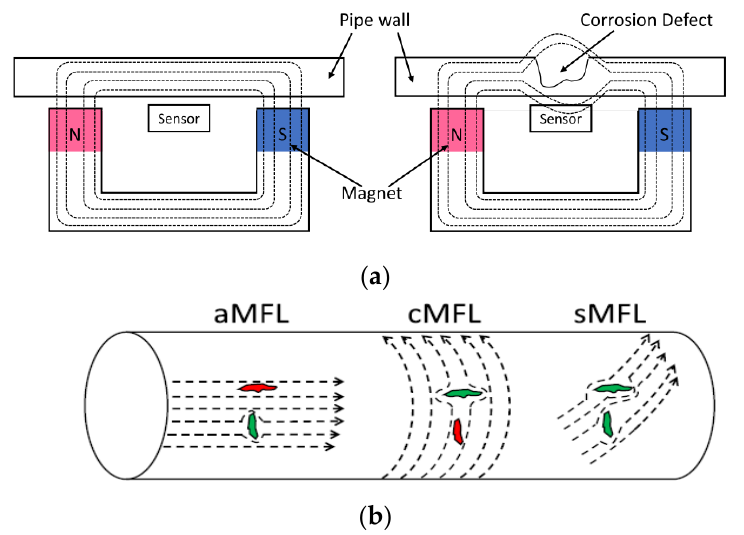
Figure 2. ( a ) Principal of MFL tool; ( b ) illustration of three configurations of axial-, circumferential- and spiral-MFL, where anomalies in red colour are not detected [7].